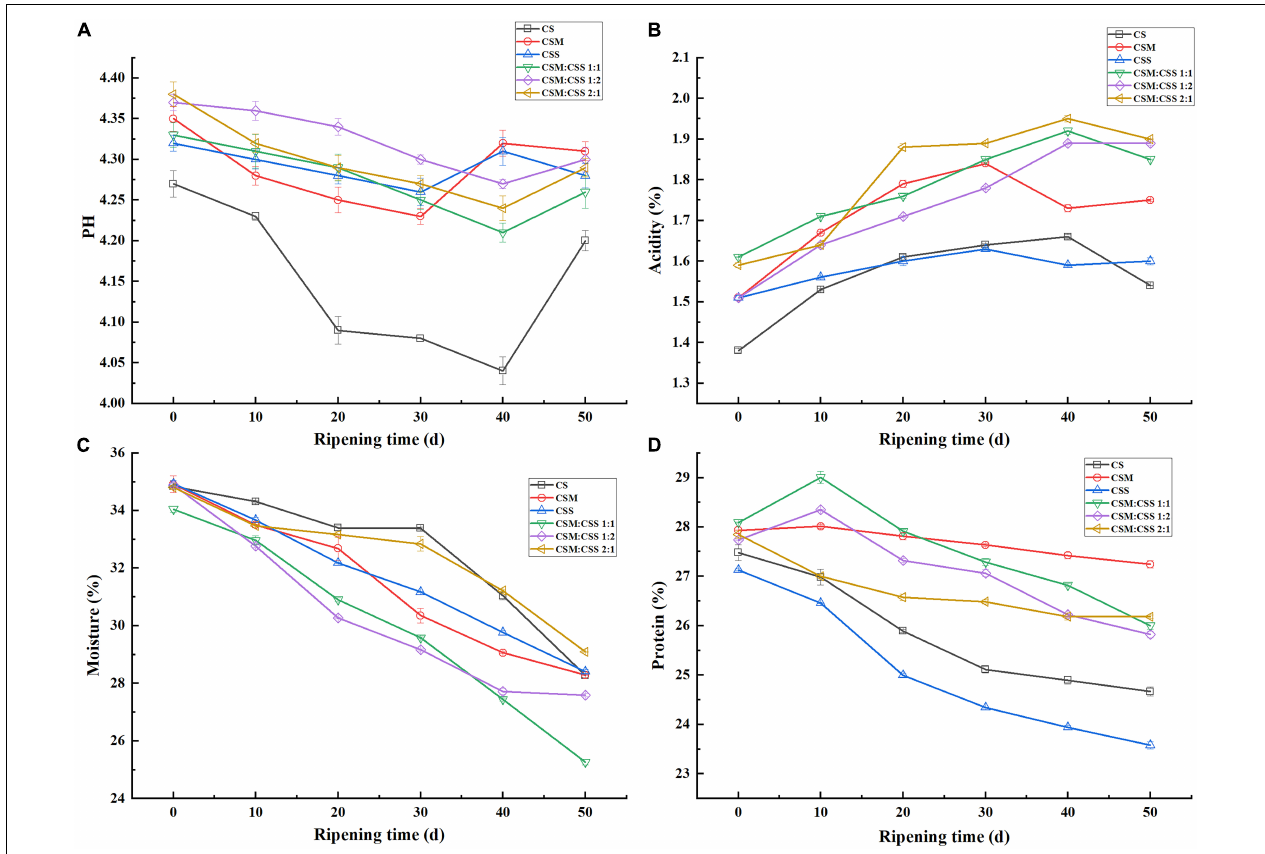
FIGURE 2 | Comparative analysis of the physical and chemical indicators of the cheeses. CS, CSM, CSS, CSM:CSS 1:1, CSM:CSS 1:2 and CSM:CSS 2:1 represent cheeses fermented using the commercial starter (Control group), K. marxianus B13–5, S. cerevisiae DL6–20, K. marxianus B13–5: S. cerevisiae DL6–20 1:1, K. marxianus B13–5: S. cerevisiae DL6–20 1: 2, K. marxianus B13–5: S. cerevisiae DL6–20 2:1. Error bars indicate standard deviations. (A–D) The changes in pH, acidity, moisture, and protein content during storage,